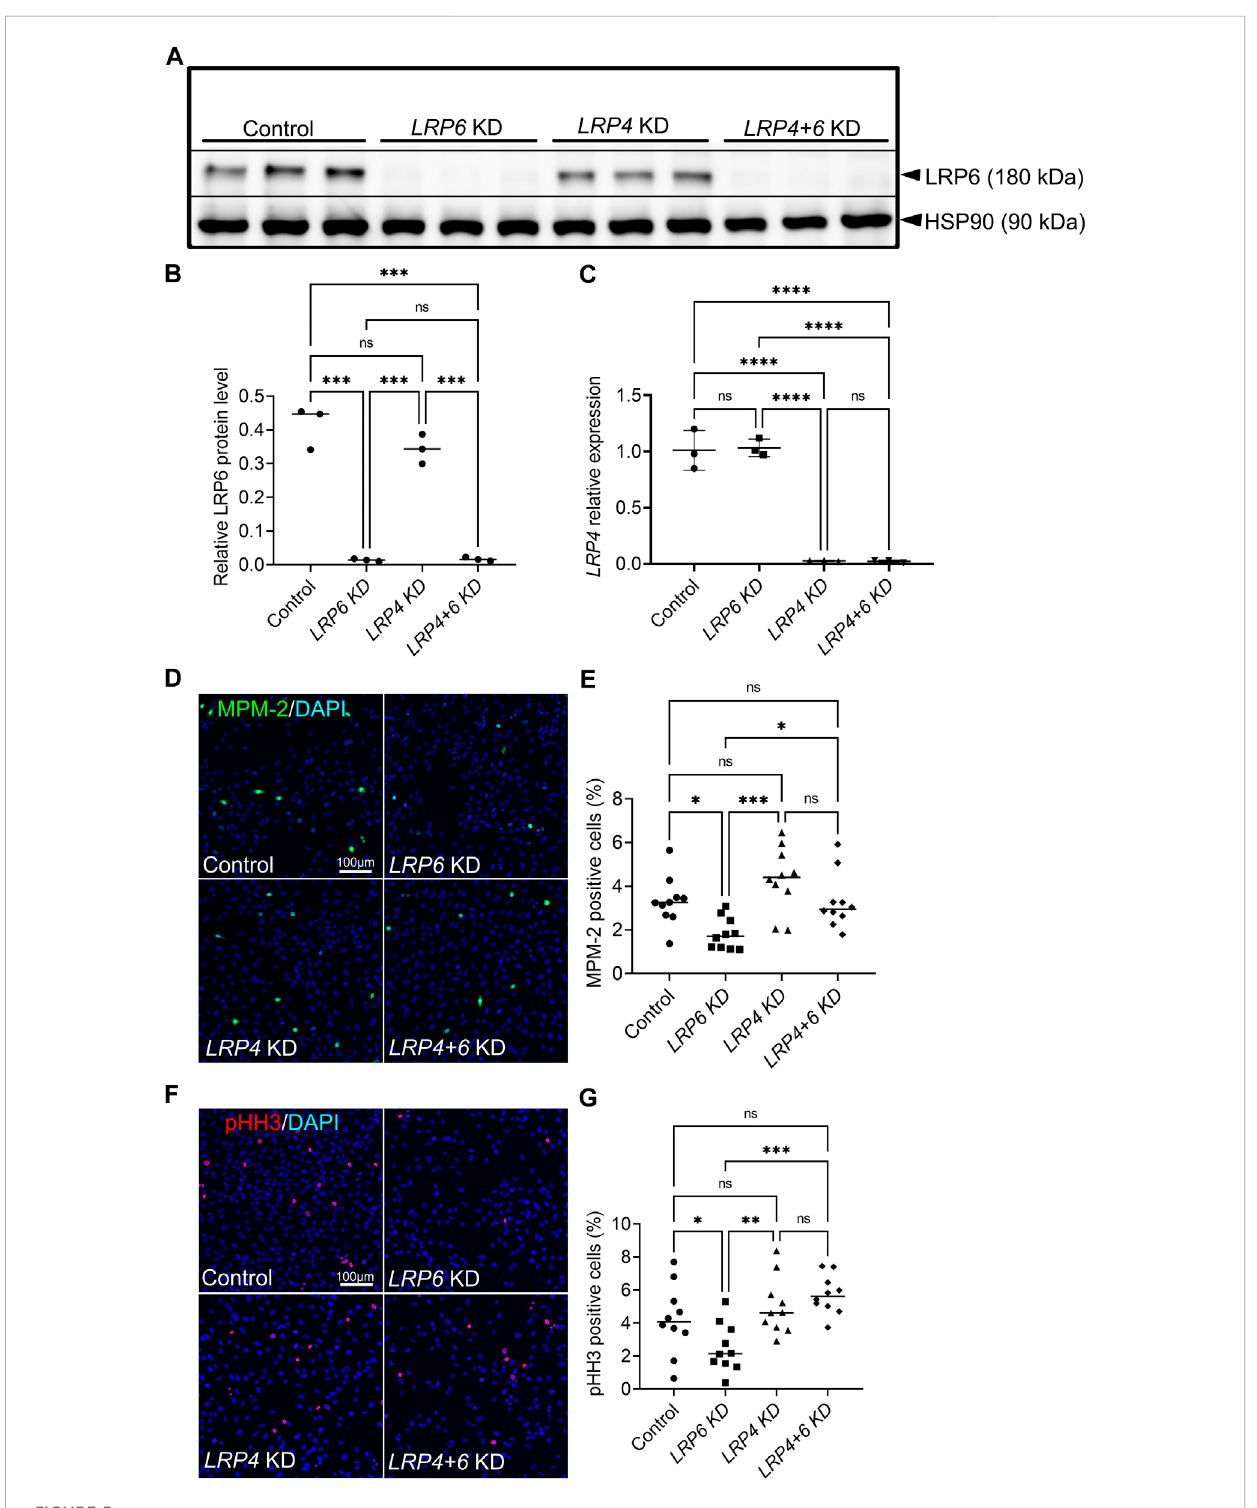
FIGURE 5 LRP4modulatesofLRP6-dependentmitoticactivityinhumanTERTRPE-1cells. (A,B) Westernblotanalysisandquanti fi cationofLRP6proteinlevels after Lrp6 siRNAandcontrolsiRNAtreatmentrespectively,demonstratedsigni fi cantlylowerLRP6proteinlevelsinhTERTRPE-1 cellsafterLRP6silencing and simultaneous LRP4 and LRP6 silencing compared to controls and compared to LRP4 silencing only. These results validate the LRP6 silencing and demonstrate that there is no up- or downregulation of LRP4 levels in Lrp6 siRNA treated cells. Quanti fi cation of LRP6 levels was normalized to HSP90 (heat shock protein 90) signals. Three independent experiments in triplicates (technical replicates) are summarized in the graph. Signi fi cance assessedbyone-wayANOVA.**** p ≤ 0.0001;dataaremean±s.d. (C) LRP4 siRNAmediatedsilencingwasvalidatedbyquantitativeRT-RCR.Signi fi cantly lower LRP4 transcription was detected in hTERT RPE-1 cells after LRP4 silencing and simultaneous LRP4 and LRP6 silencing compared to controls